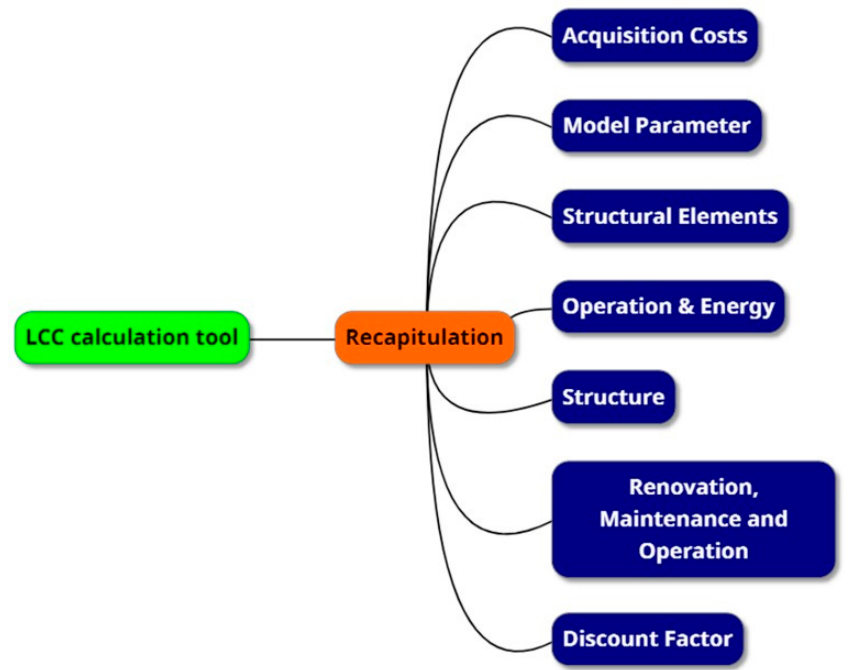
Figure 1. Structure of the LCC calculation tool.